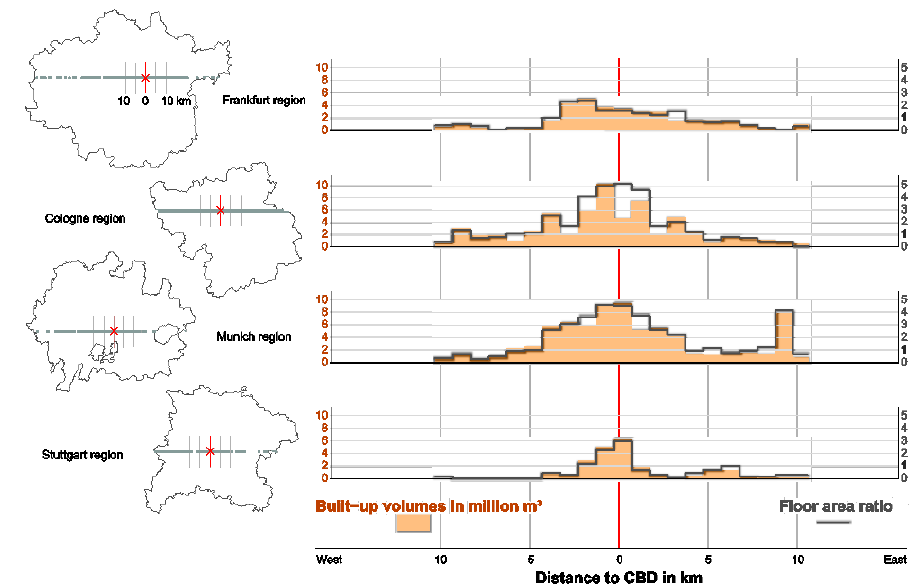
Figure 8. Selected density profiles of the case study regions; built-up volume and floor area ratio values for the grid cells located along the respective core city’s latitude, the latter indicated by the town hall’s geographic location.